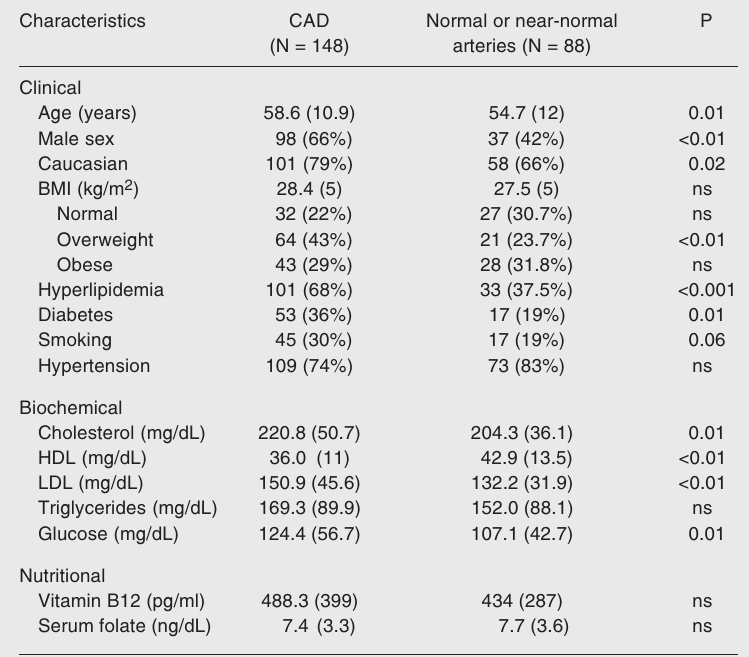
Table 1. Clinical characteristics of 236 patients with and without coronary artery disease (CAD).